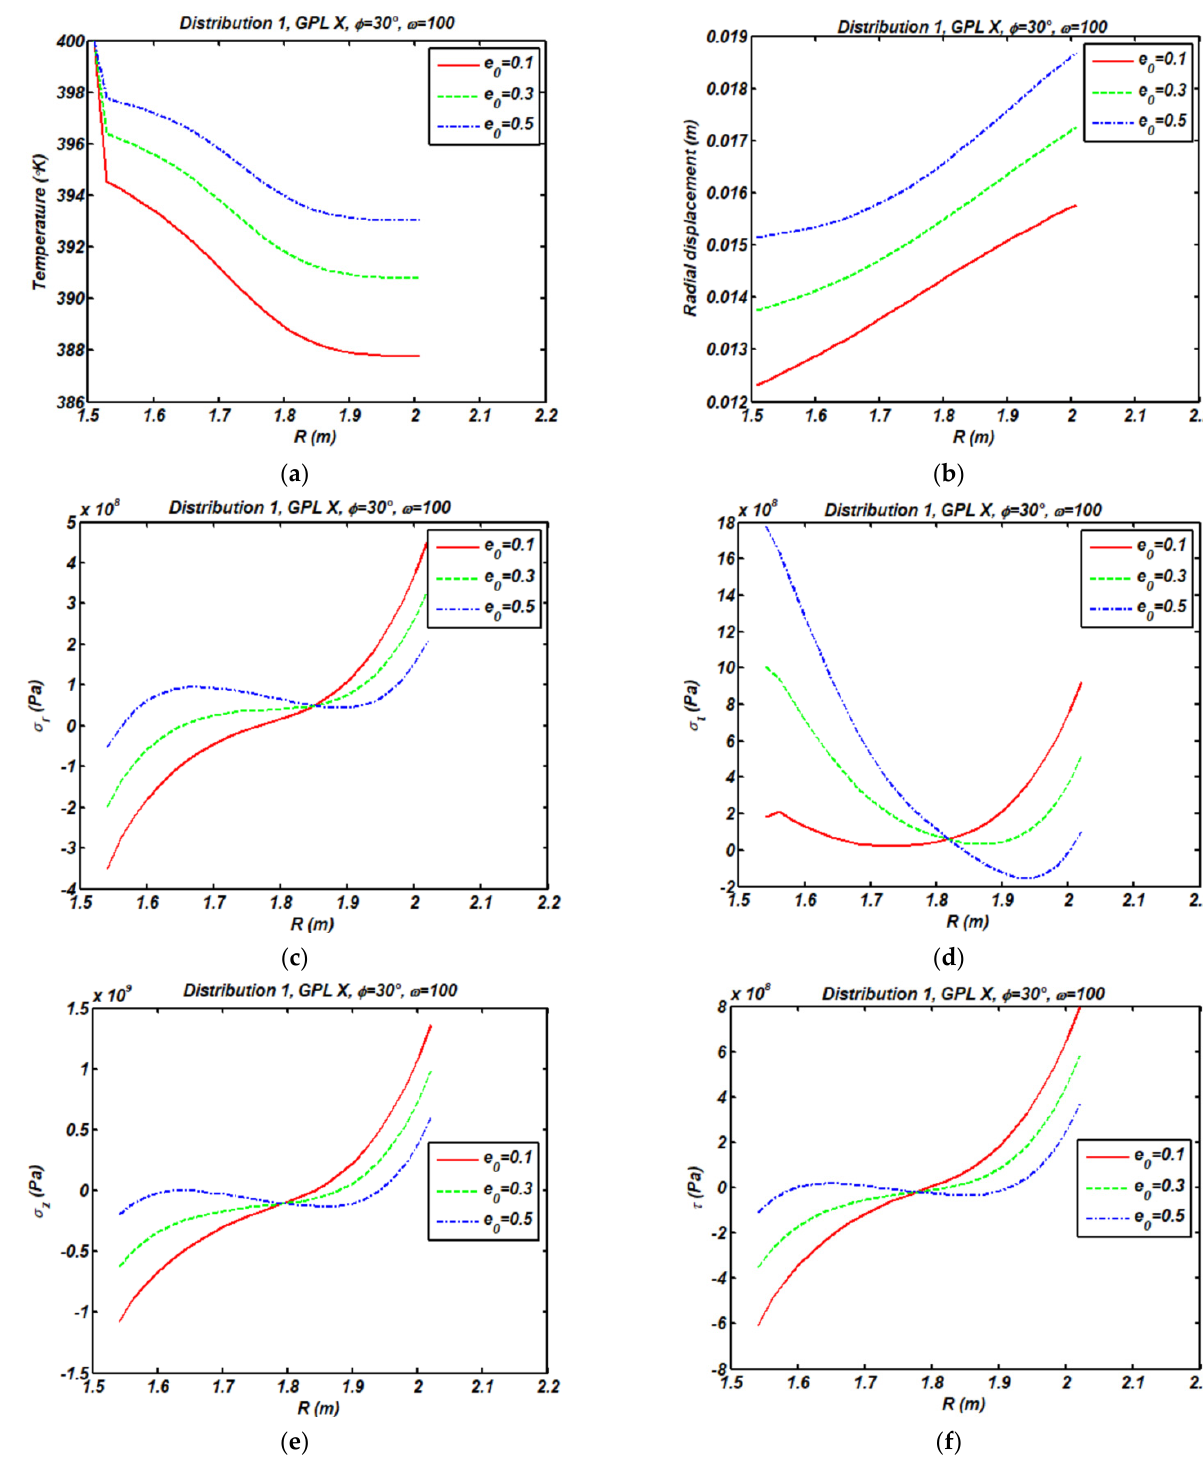
Figure 11. Temperature ( a ), radial displacement ( b ), and stress state ( c – f ) at z = L/2 for various porosity coefficient (D1-GPL X; φ = 30 ◦ ; γ GPL = 0.01; ω = 100